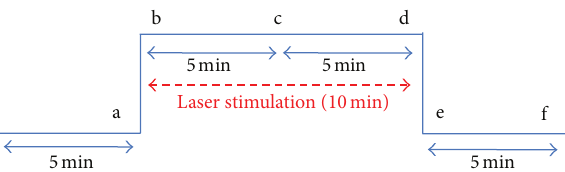
Figure 4: Experimental protocol.